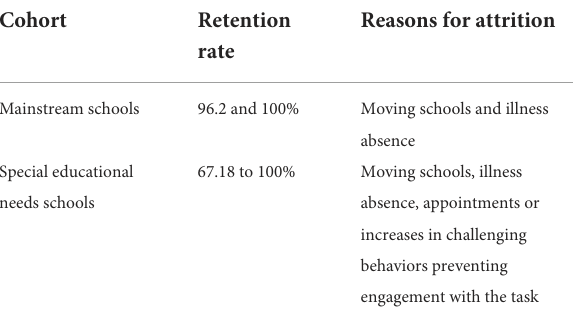
TABLE 2 Retention rates and reasons for attrition per school